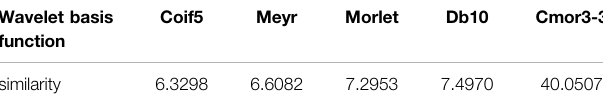
TABLE 1 | The similarity of fi ve commonly used wavelet basis functions. Wavelet basis